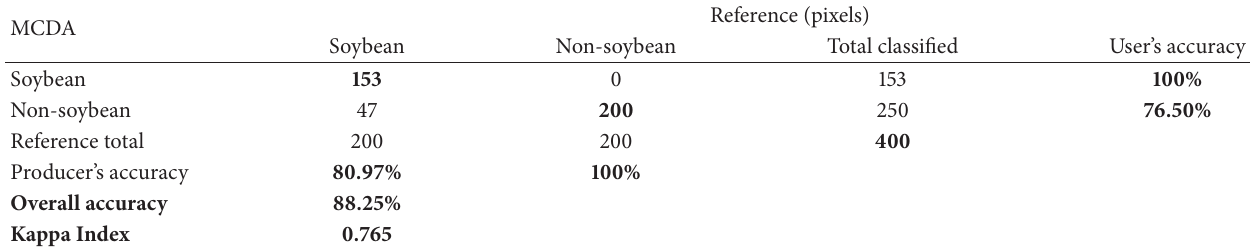
Figure 4: Comparison of the MCDA (second forecast), IBGE, and CONAB soybean area estimates for the Mato Grosso State and percent difference from MCDA. Table 1: Confusion matrix from the comparison of MCDA and field campaign